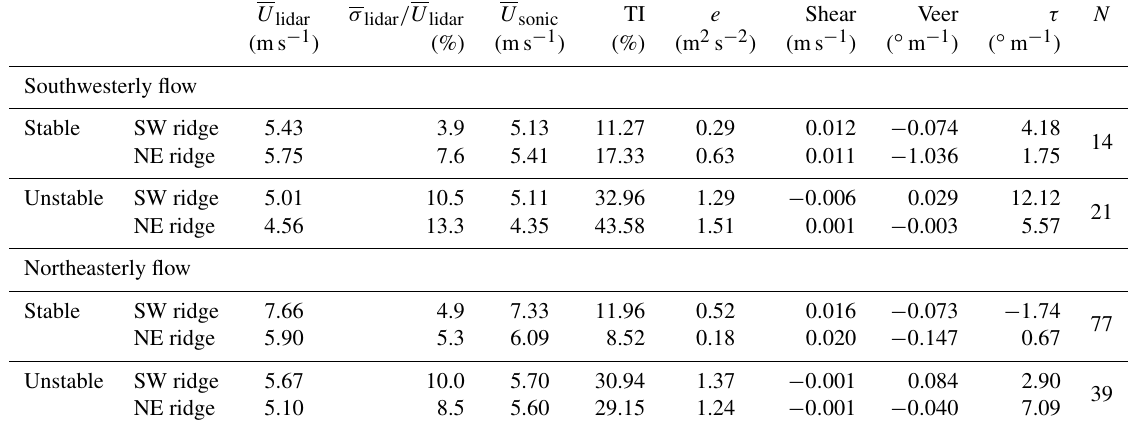
− 1 Table 3. Observation from tower tse04 (SW ridge) and tse13 (NE ridge). Turbulence intensity is defined as TI = σ U U sonic , where U sonic is (cid:104) (cid:105) u (cid:48) 2 + v (cid:48) 2 + w (cid:48) 2 the mean wind speed and σ U the standard deviation of U sonic . Turbulent kinetic energy is calculated as e = 1 , where u (cid:48) , 2 v (cid:48) , and w (cid:48) are the fluctuating parts of the wind vector components as measured by the sonic anemometers. Wind shear and veer are calculated − 1 (cid:112) u 2 + v 2 over 60m (40–100ma.g.l.). The flow inclination angle τ is calculated as arctan( w ), where u and v are the mean horizontal wind vector components and w the vertical. All averages are taken over 10min. U lidar is the mean of the wind speeds measured by the lidars averaged over the entire ridge. σ lidar is the standard deviation also averaged along the ridge. N is the number of available 10min periods. U